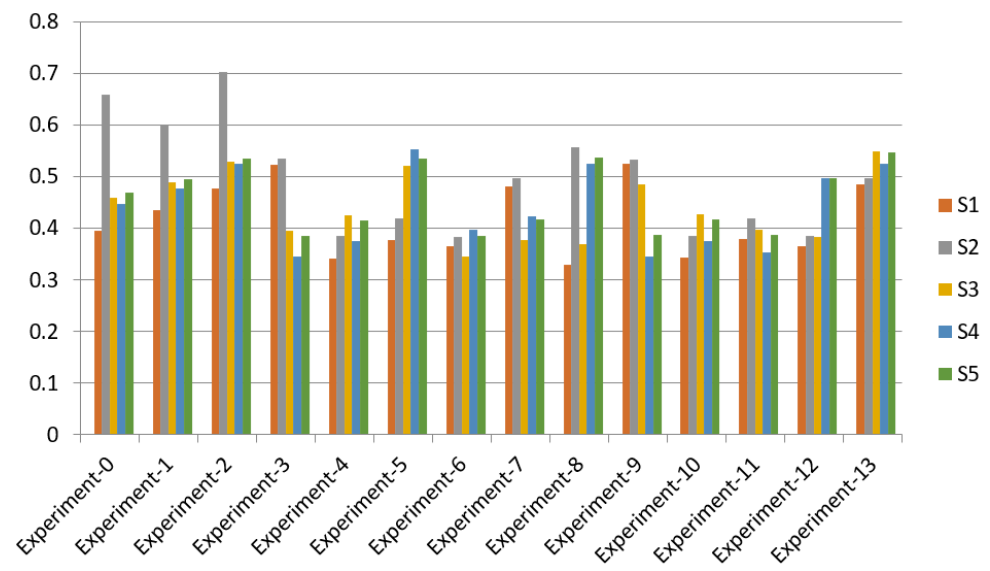
Figure 6. Sensitivity analysis.